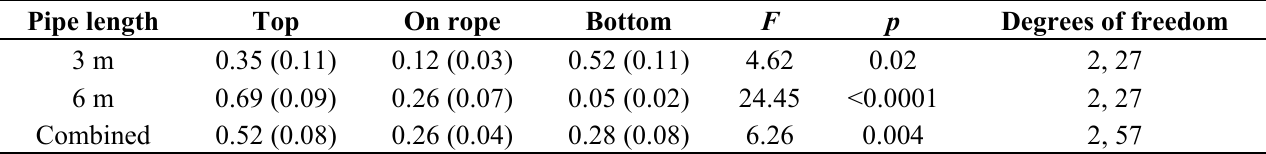
Table 1. Mean (±1 Standard Error) proportion of redfin bully Gobiomorphus huttoni in either the top chamber, ascending the culvert, or in the bottom chamber of 3 m and 6 m treatment pipes post trial, in a simulated culvert system with mussel spat ropes installed (n = 10 replicates of each length; 30 fish per replicate; control and treatment run for every